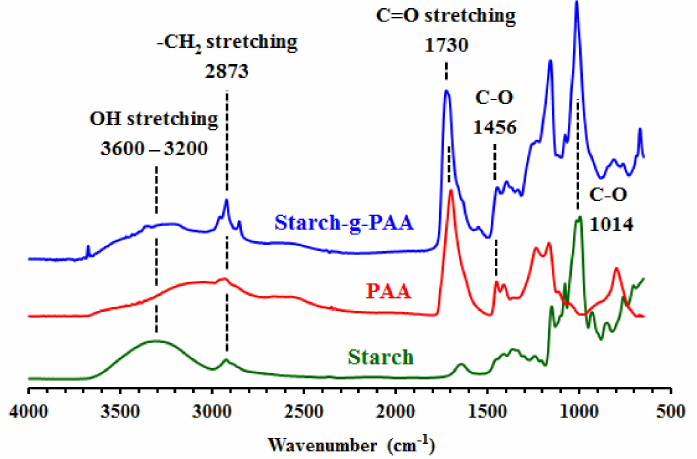
Figure 4. FTIR spectra of starch, polyacrylic-acid-(PAA) and starch- g -PAA